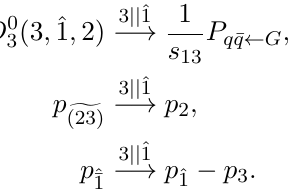
Figure 2 . A subset of Feynman diagrams contributing to the matrix element B (cid:13); 0 with indicative momentum labels for the external